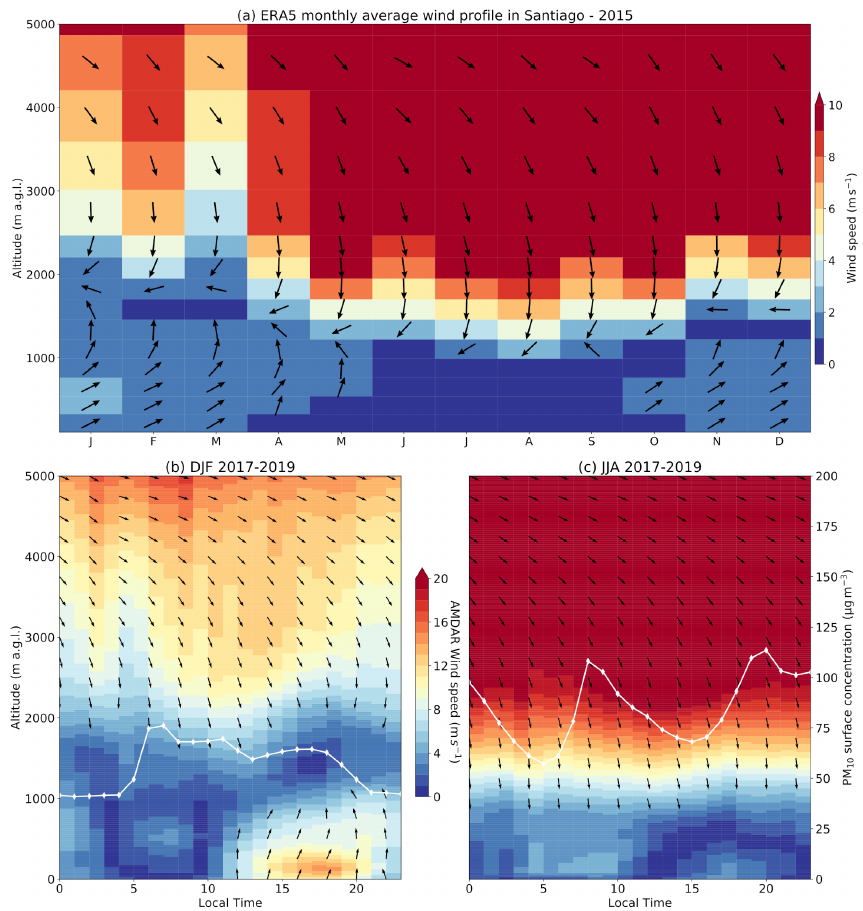
Figure 7. (a) Monthly wind vertical profile in Santiago for 2010–2020. Colors indicate horizontal wind speed; arrows indicate the meteo- rological direction of horizontal winds (i.e., upwards is southerly, rightward is westerly). Directions are displayed for average wind speeds above 1ms − 1 only. Average of monthly means from ERA5 pressure-level reanalysis for the grid point located at 33.5 ◦ S, 70.75 ◦ W. (b) Average daily cycle of wind vertical profiles in Santiago from AMDAR for DJF 2017–2019 (color map) and corresponding PM 10 surface concentration daily cycle (white line) at Parque O’Higgins (PQH) station (data from SINCA). Panel (c) same as (b) for